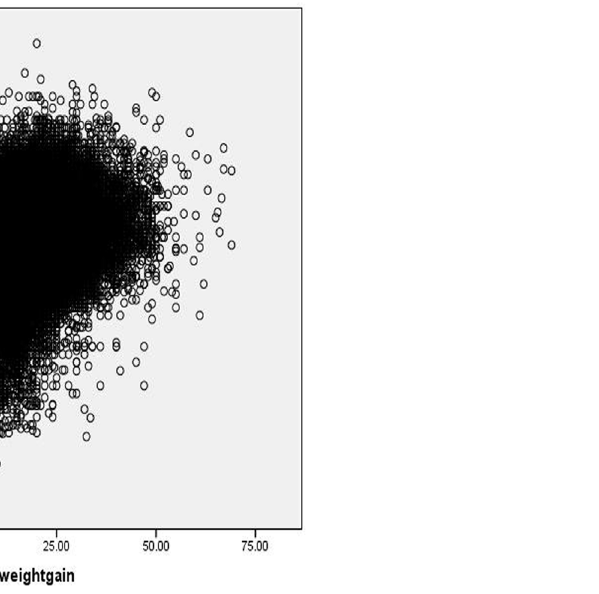
Fig 1. Scatter diagram of birth weight and weight